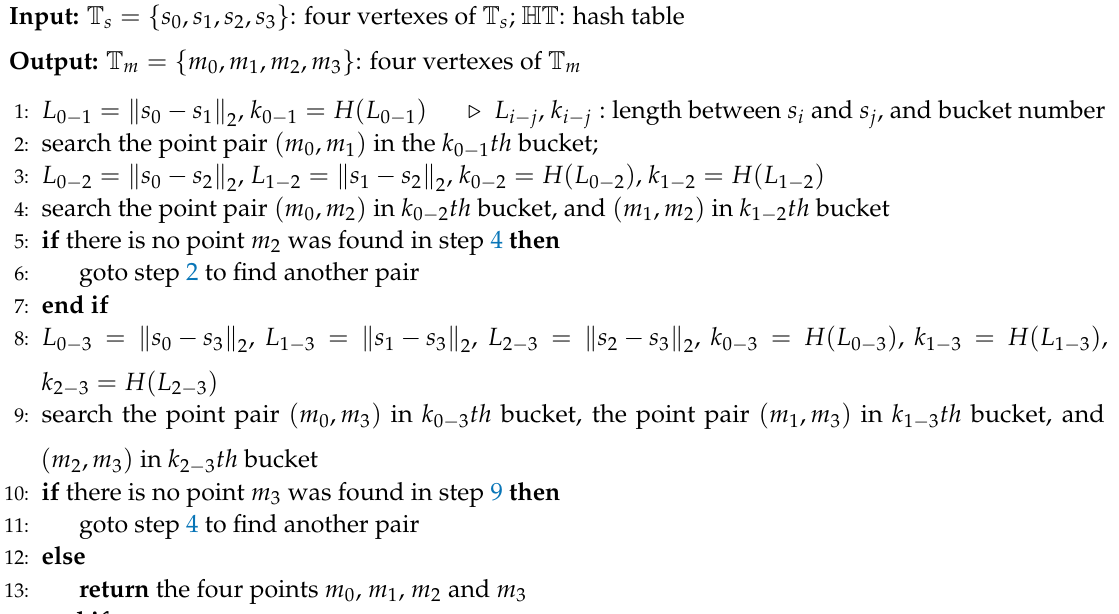
Algorithm 1 Searching the congruent